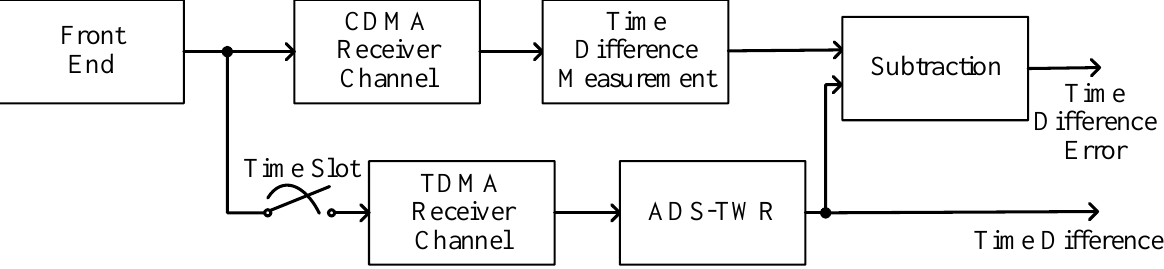
Figure 7. Simulation results of the overall time difference error.